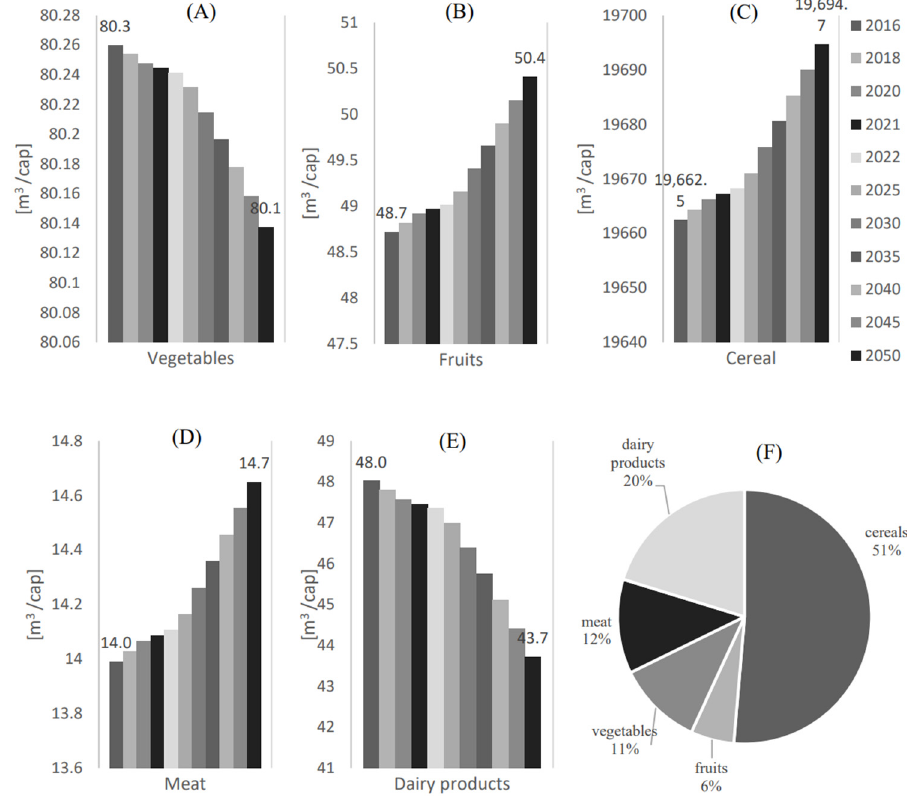
Figure 10. Water consumption ( V w , i ) per capita [m 3 /cap] for the additional local food supply to achieve food self-sustainability ( x i , add ) for ( A ) Vegetables, ( B ) Fruits, ( C ) Cereals, ( D ) Meat, ( E ) Dairy products. ( F ) Water consumption share ( V w , i / V tot ) for each food category.